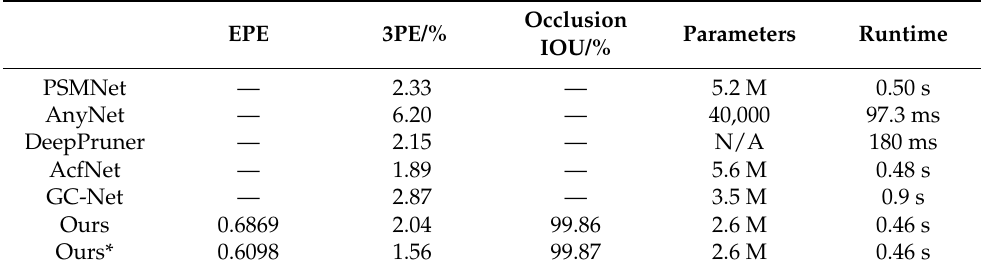
Figure 16. Partial experimental results on KITTI dataset based on our algorithm. Table 4. Quantitative evaluation on the KITTI 2015